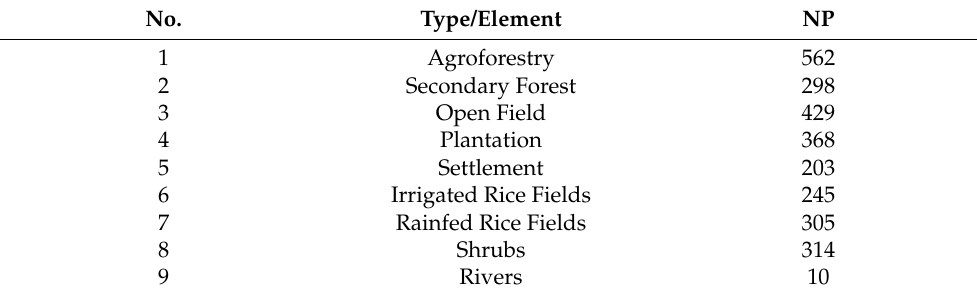
Table 7. Number of patches (NP) of each landscape element in the study area.